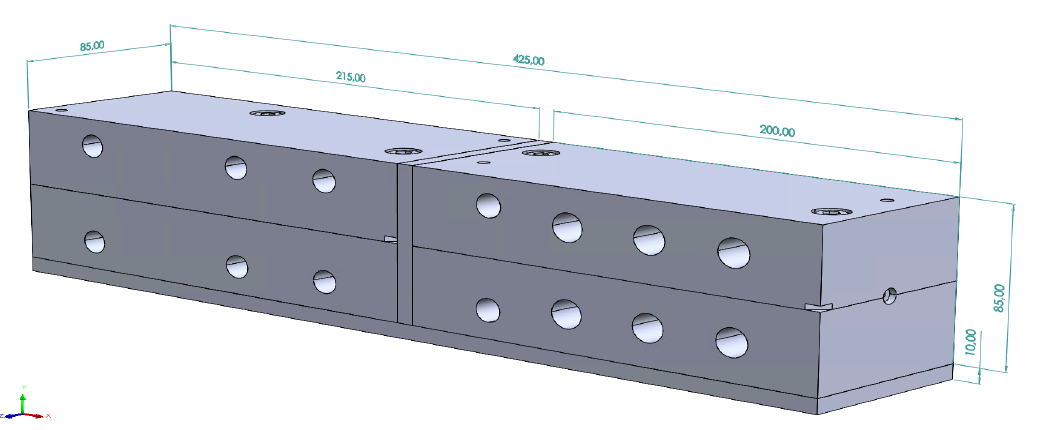
Figure 5. Dimensions for the pultrusion die.